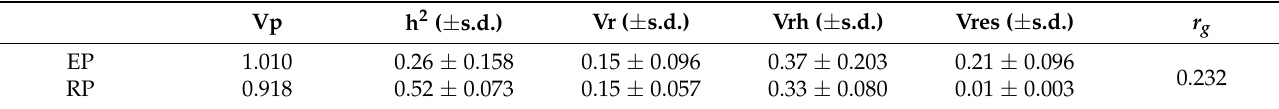
Table 3. Phenotypic variance, mean, and standard deviation of the marginal posterior distributions for the heritabilities of horse, rider, rider–horse interaction, residual effects, and genetic correlation ( rg ) between both eye temperature variables analyzed, where EP is effort phase, RP is recovery phase, Vp is phenotypic variance, h 2 is animal heritability, Vr is variance of rider effect/phenotypic variance, Vrh is variance of rider–horse interaction effect/phenotypic variance, Vres is variance of residual effect/phenotypic variance, and s.d. is standard